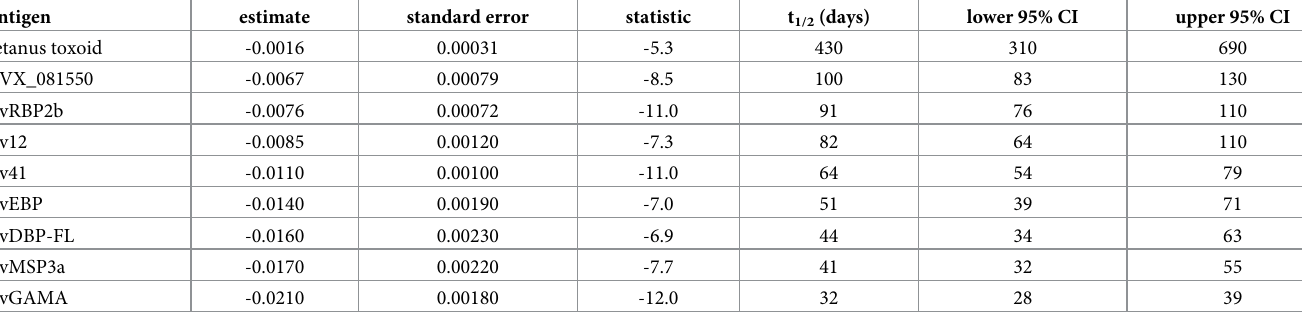
A linear mixed effects regression with ln(reactivity) as the dependent variable and time (days) and subject as fixed and random effects, respectively. Half-life (t 1/2 ) was calculated as